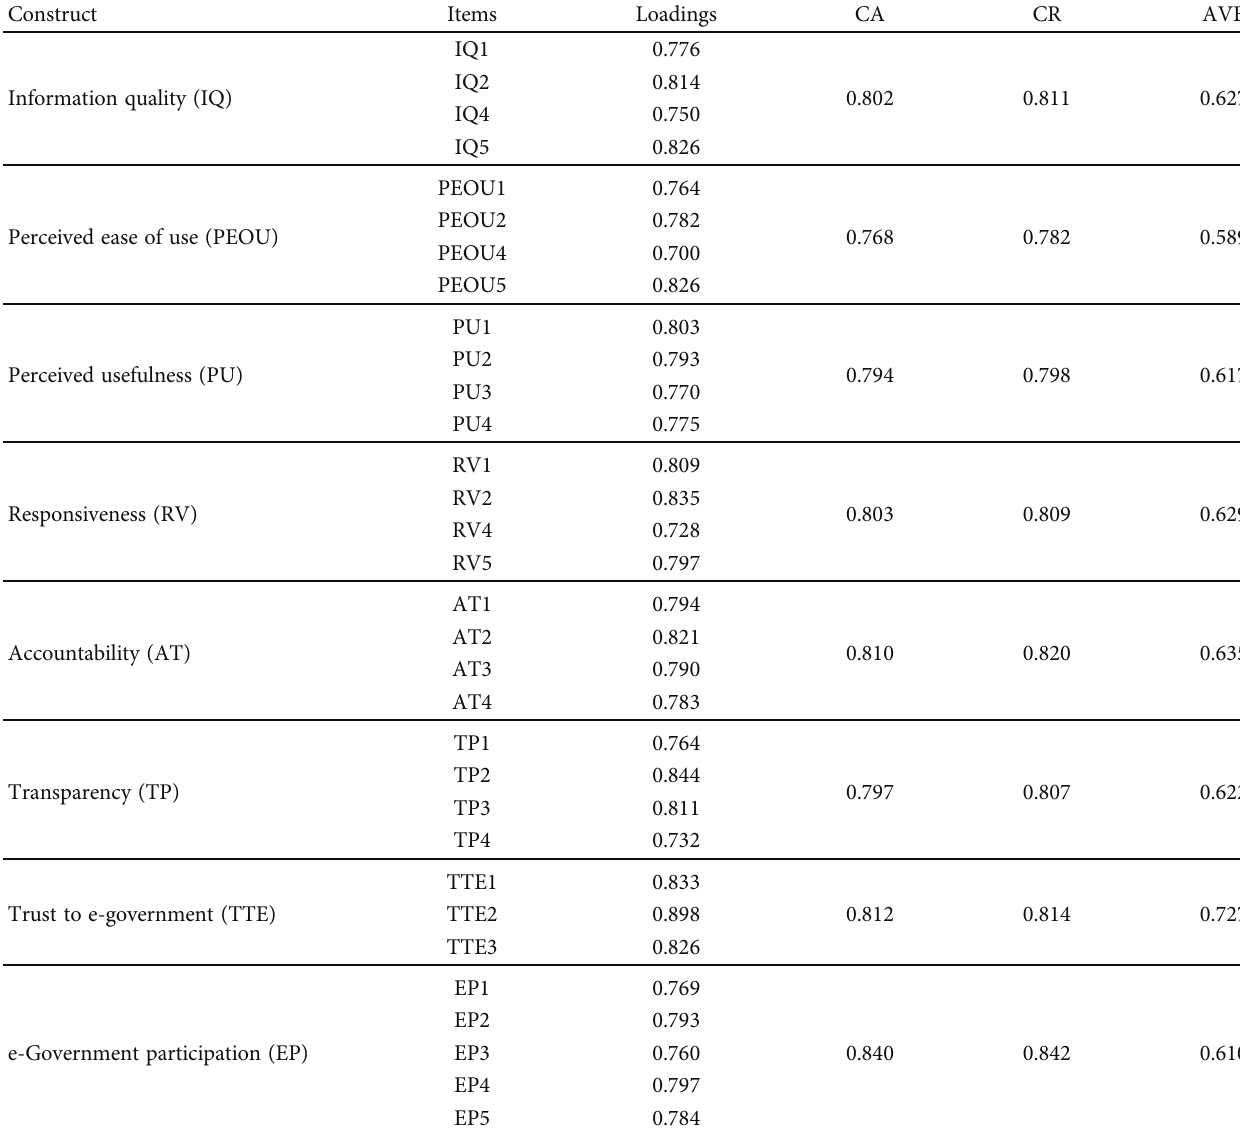
Table 3: Convergent validity and internal consistency.